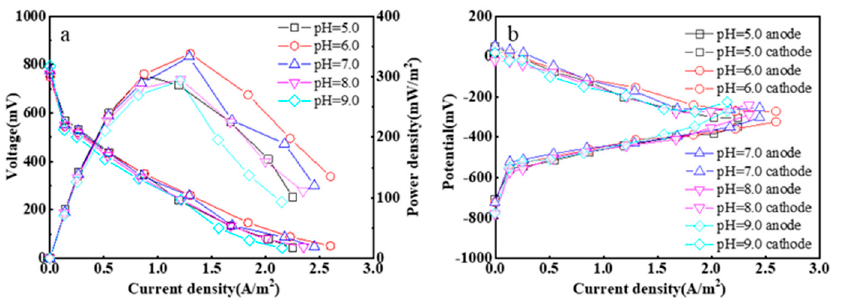
Figure 5. ( a ) Power density and polarization curves and ( b ) electrode potential curves for the aluminum − air fuel cell with different initial pH. Table 1. The pH value changes of the aluminum–air fuel cell before and after operation for 60 min.